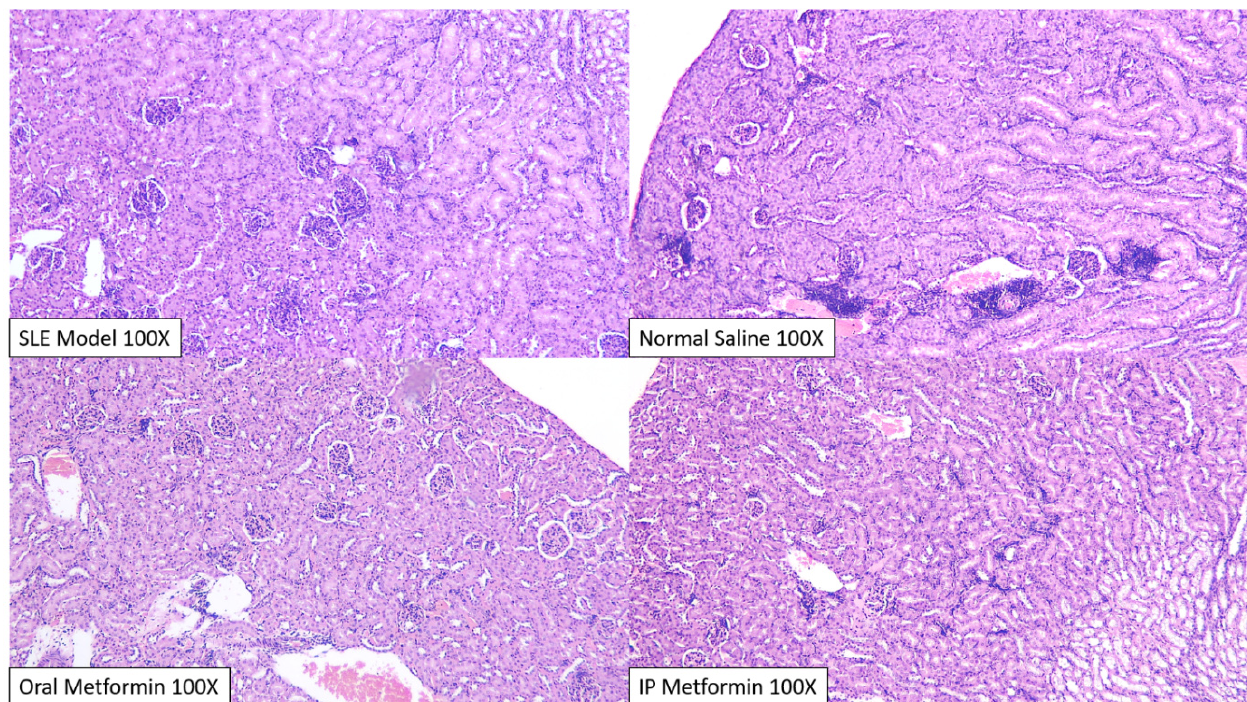
Figure 4. Kidney of BALB/c mice stained with hematoxylin and eosin, after intervention. In general, there was a widespread and significant glomerular and interstitial change across all groups, consistent with previous SLE models. Tubulo-nephritic changes significantly happens more than glomerulo-nephritis, although significant interstitial infiltration only happens in the normal saline group (upper right), especially in two members of its group. Qualitatively, two blinded pathologists concluded that the most severe changes happen in the normal saline group and the least severe in the intraperitoneal metformin